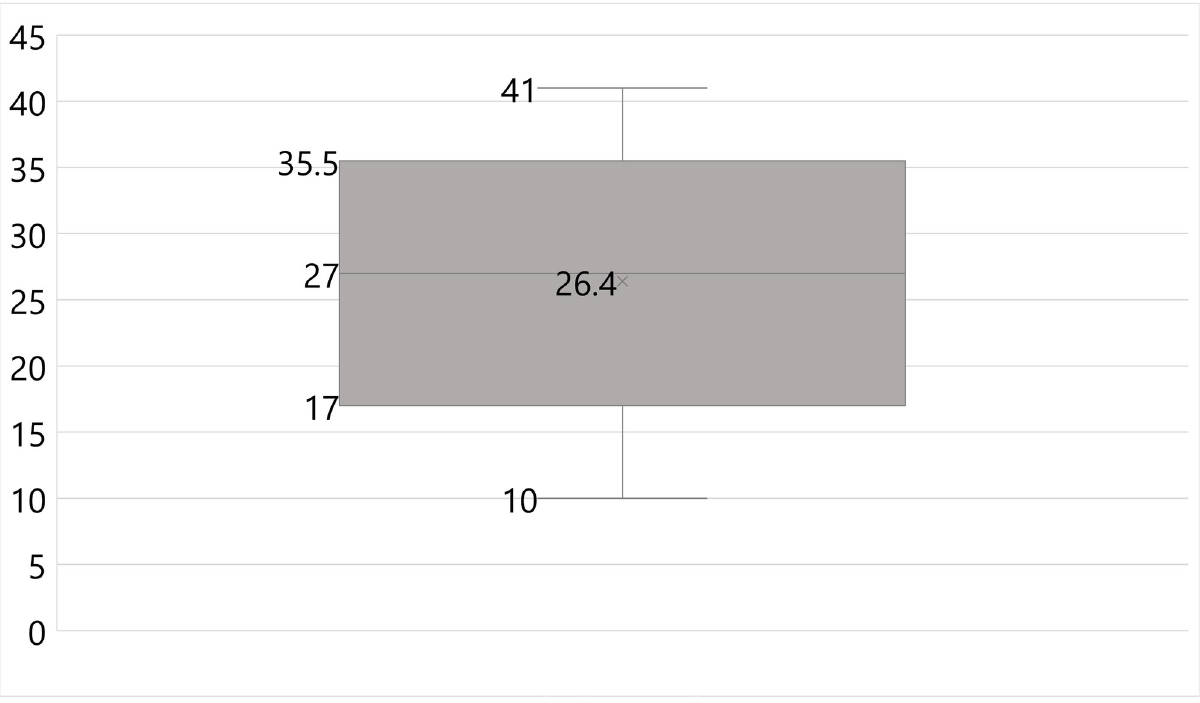
Fig 1. Food safety knowledge among participants (n = 354).